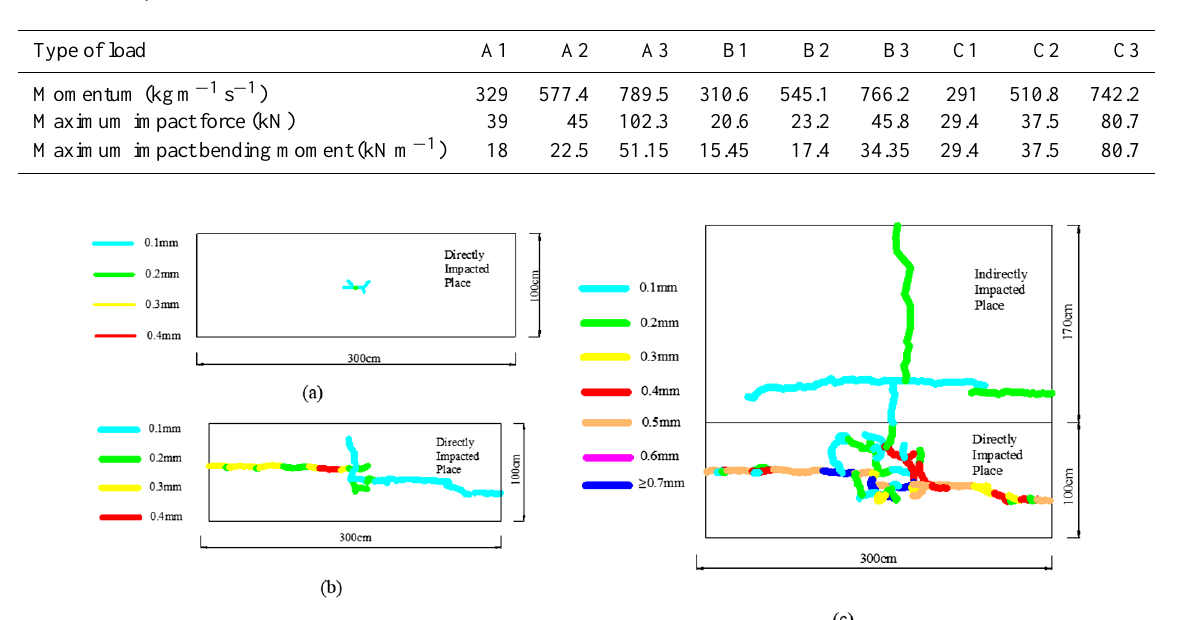
Table 3. Loads in experiments.